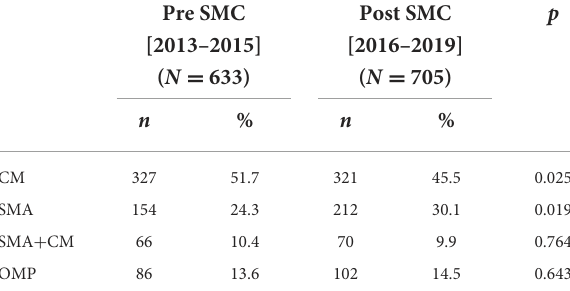
TABLE 2B Distribution of severe malaria clinical phenotypes in the National Hospital of Mali record survey. Pre SMC Post SMC